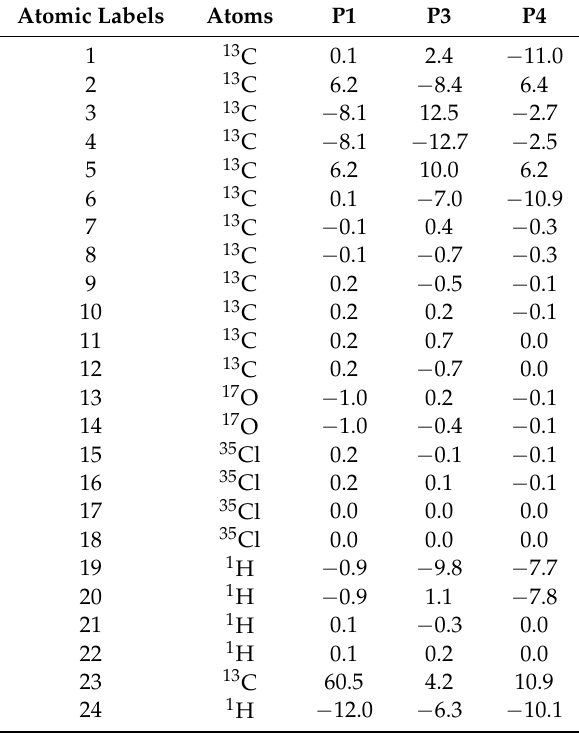
Table 3. Calculated hyperfine coupling constants for the atoms in P1, P3, and P4 a . Atomic Labels